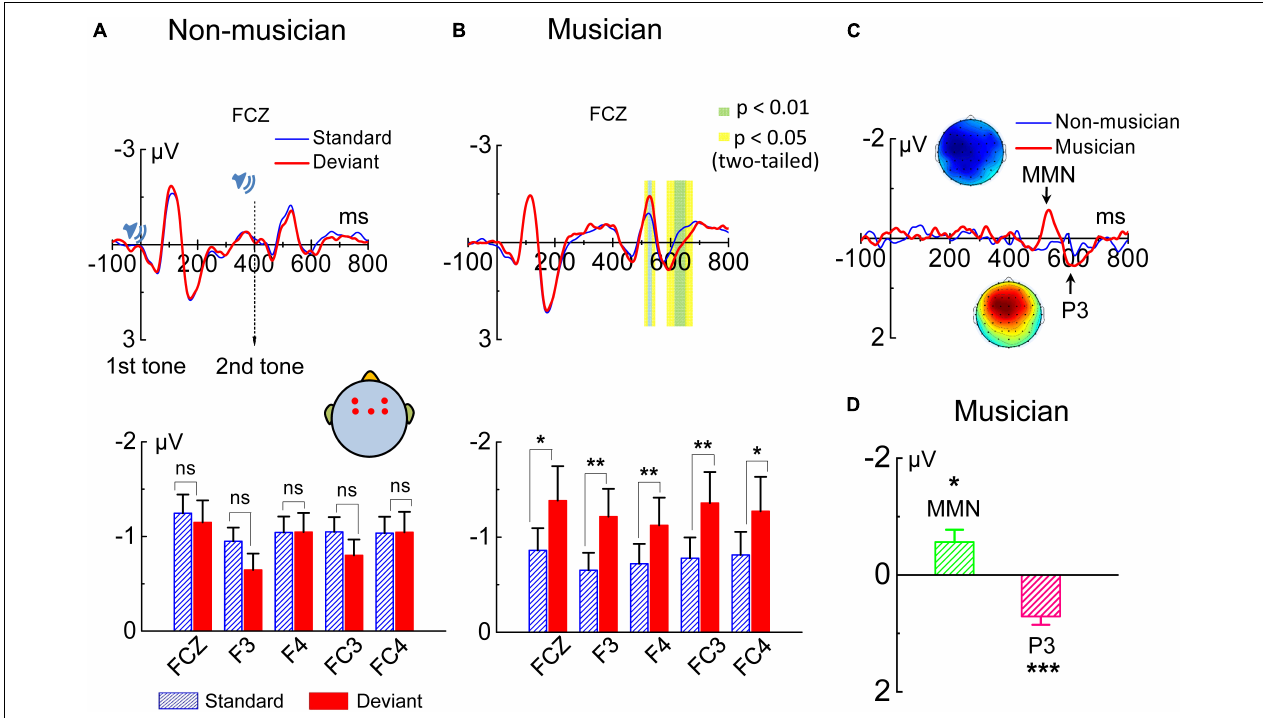
FIGURE 2 | Grand average event-related potential (ERP) at electrode FCz. ERPs evoked by standard and deviant tone pairs, as well as deviant-minus-standard difference waveforms are plotted for groups of non-musicians and amateur musicians. (A) No MMN evoked in the non-musician group ( p ≥ 0.05). (B) Amateur musician group extracted significant MMN amplitudes. Significant effects are marked with green and yellow areas in the waveforms. In the bar plots, significant effects are marked with asterisks ( *p ≤ 0.05, ** p ≤ 0.01). (C) Difference wave evoked in non-musicians (blue lines) and amateur musicians (red lines). ERP waveforms at the peak amplitude of MMN and P3 in the oddball paradigm of amateur musician group and the corresponding topographic map of MMN and P3 are shown. (D) Bar plots for MMN and P3 in the amateur musician group. Significant effects are marked with asterisks ( *p ≤ 0.05, ***p ≤